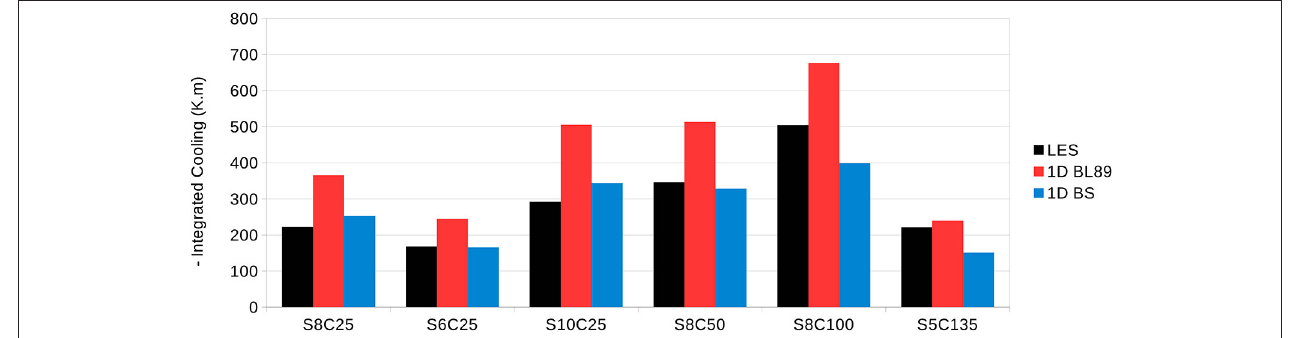
FIGURE 9 | Integrated cooling (Equation 29) between the start and the end of the simulations for the stably stratified cases (S8C25, S8C50, S8C100, S5C135, S6C25, and S10C25; see Table 1 ) performed by the reference LESs, the original SCM (1D BL89), and the modified SCM with the new length scale (1D BS).